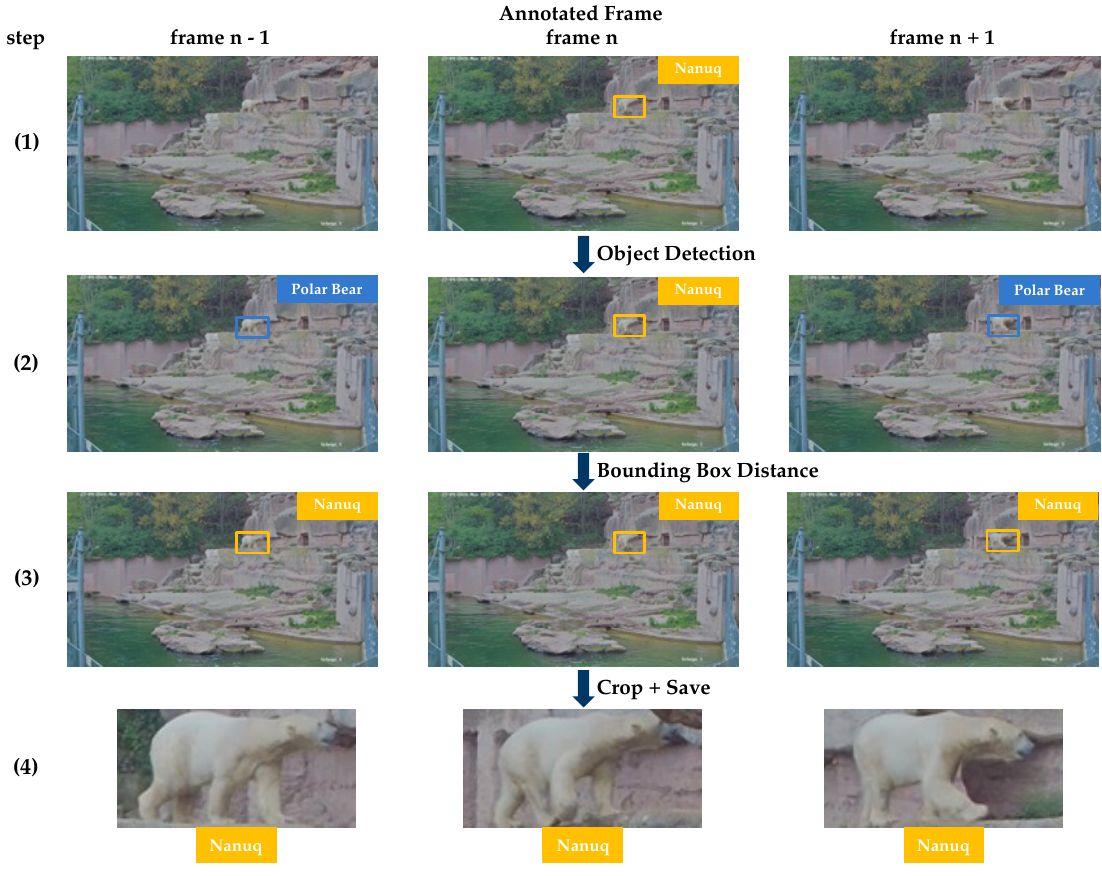
Figure 3. Approach to creating the sequences. For each image labeled by the experts, there is a bounding box including information about the identity of the animal (step 1). The adjacent images are then searched for polar bears in the second step, using an object detection algorithm. To ensure that the correct animal is tracked, we compute the bounding box distances between two consecutive images. If this is below a threshold, we can assign the same ID to the found animal (step 3). In step 4, the bounding boxes are then cropped and saved as a